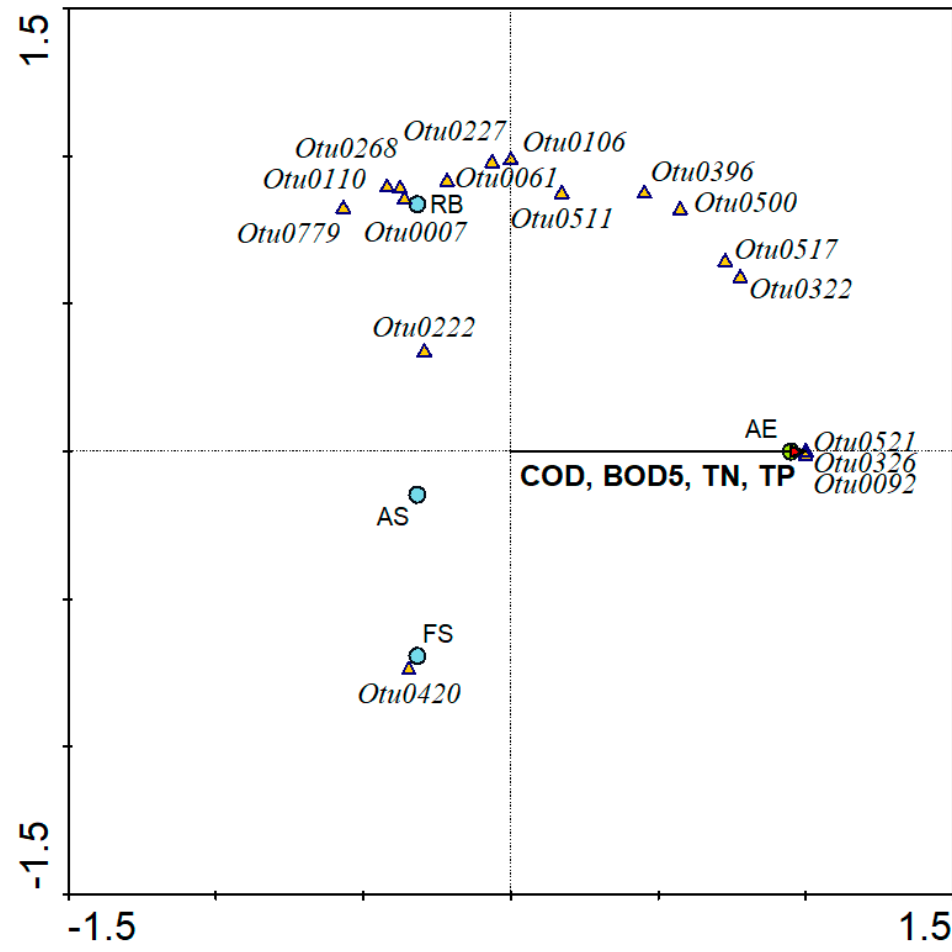
Figure 7. Multivariate redundancy analysis of dominant viral OTUs with physicochemical parameters and samples. IW: influent wastewater; EW: effluent water; ES: excess sludge; and ML: mixed liquor from an aerobic bioreactor. COD: chemical oxygen demand, BOD 5 : biological oxygen demand, TN: total nitrogen; TP: total phosphorous. OTU affiliation is shown in Figure 2.